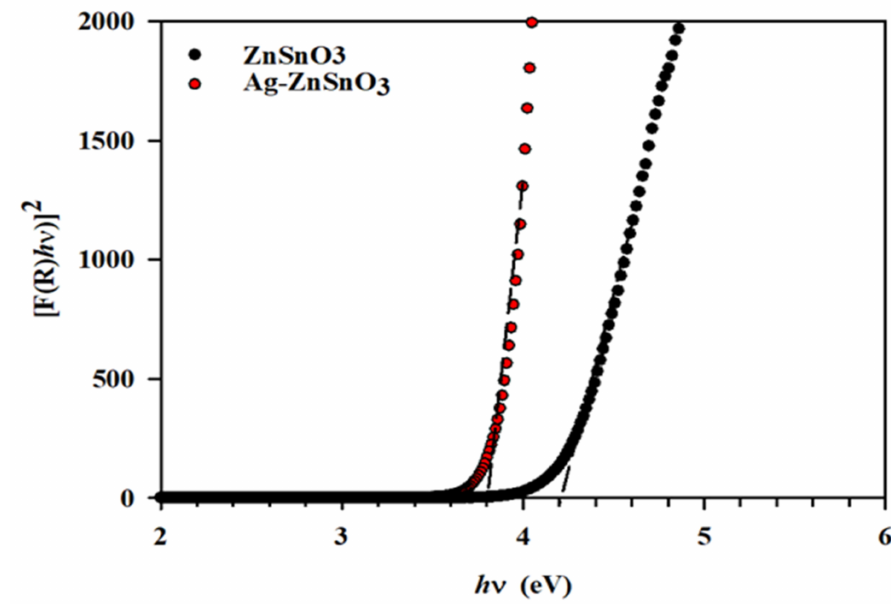
Figure 6. Tauc’s plot for energy band gap of ZnSnO 3 (black line), and Ag-ZnSnO 3 (red